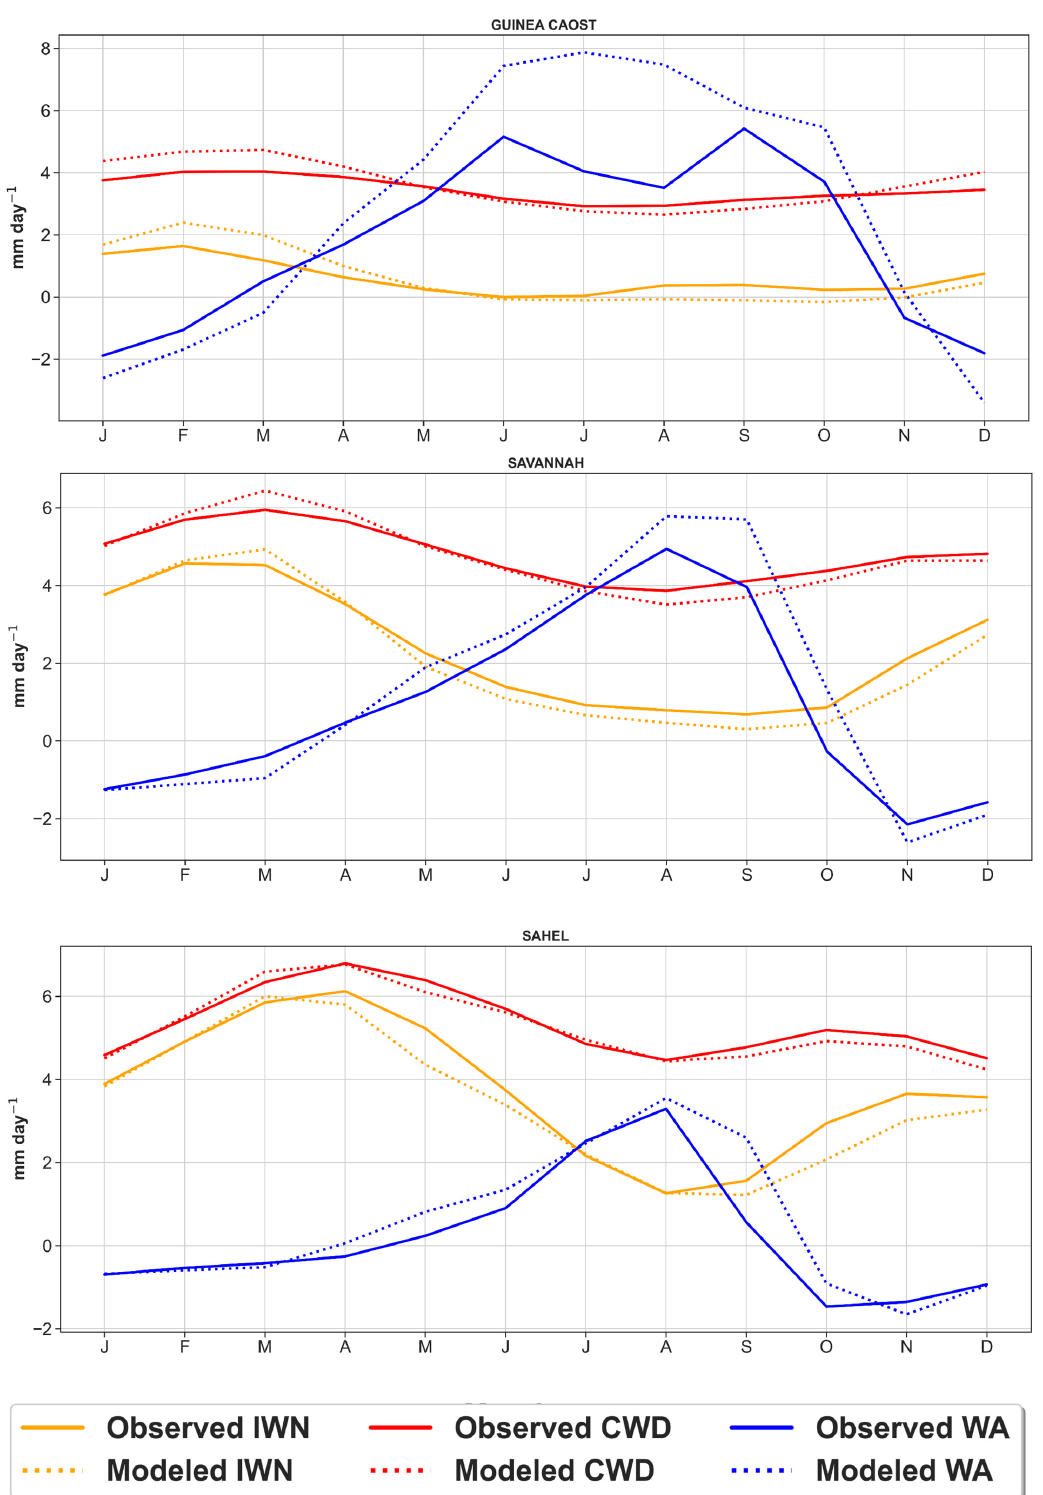
Figure 2. Annual cycle of daily mean CWD, IR, and WA (mm/day) for selected three sub-regions for the period 1981–2005. The continuous lines are meteorological observation-derived values, while the dotted lines represent estimation from the ensemble mean model simulations. HETo estimates are used for CWD and IWN/IR.